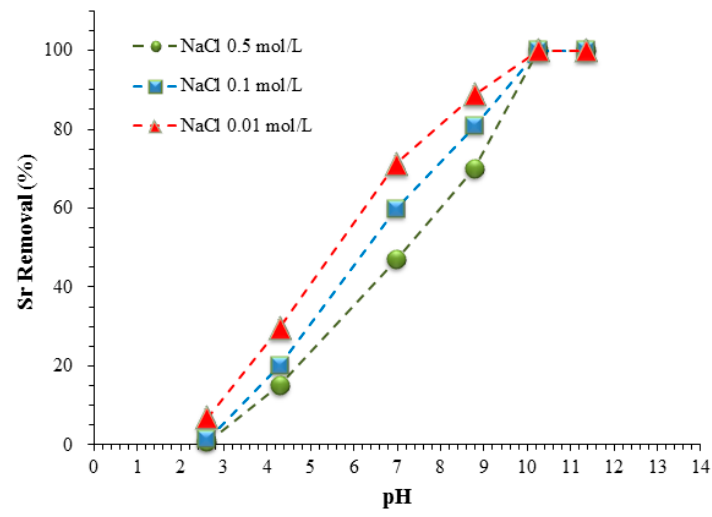
Figure 2. The Strontium (Sr) adsorption by the composite magnetic nanoparticles at various pH values. Conditions: Adsorbent dose 5 g ∙ L − 1 , T 298 K, contact time 120 min, initial Sr concentration 10 mg ∙ L − 1 .